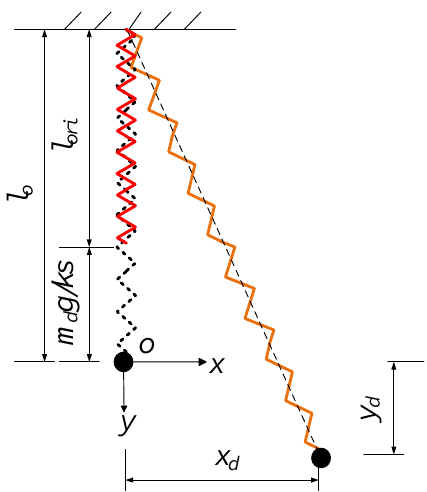
Figure 2. Schematic of the spring pendulum (SP).